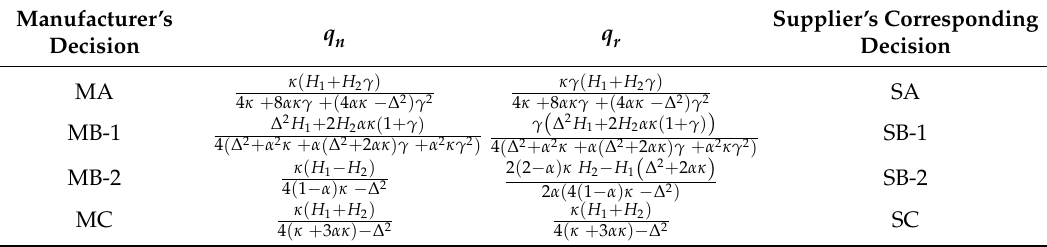
Table 3. The manufacturer’s optimal production decision.